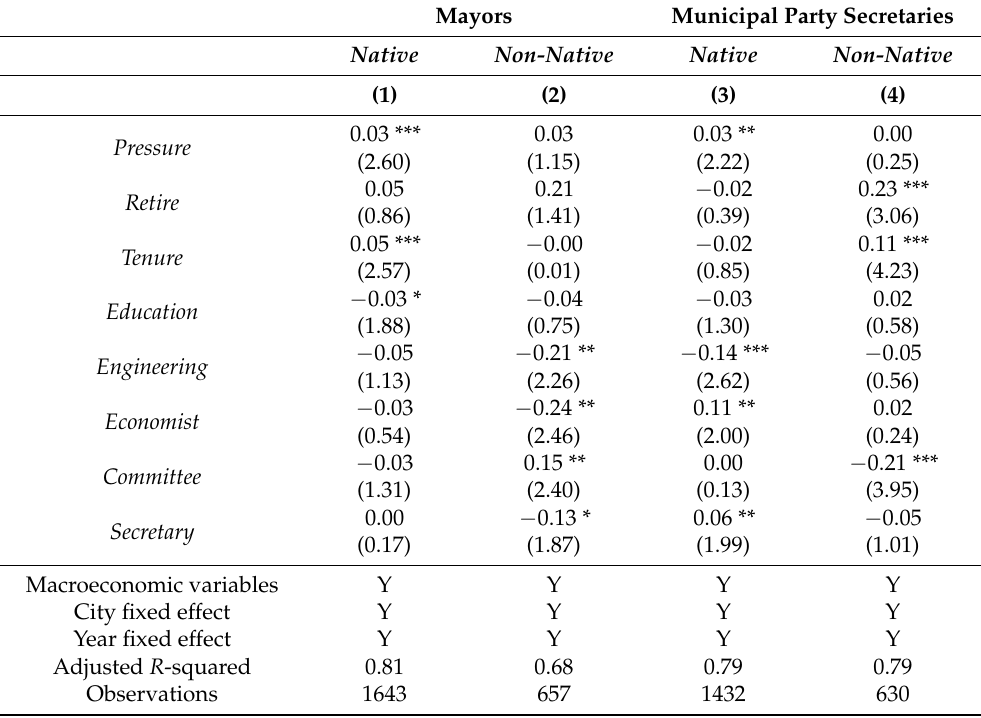
Table 5. Promotion pressures of different hometown